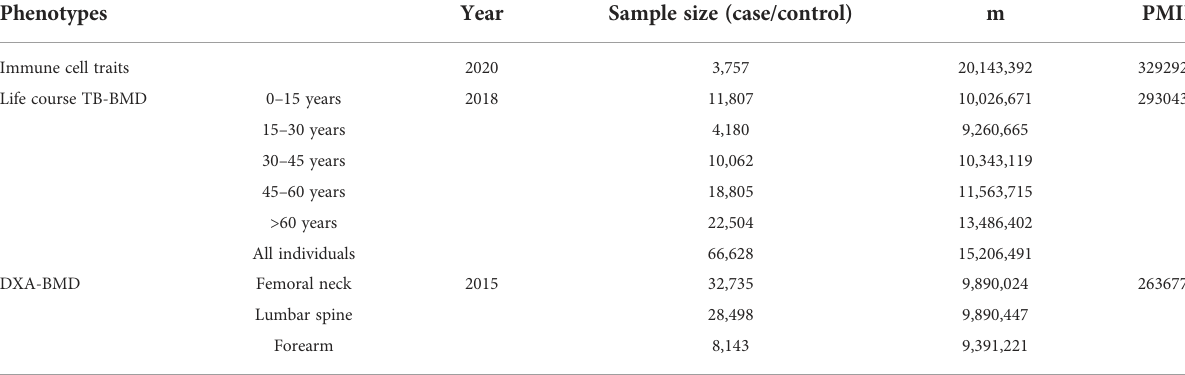
TABLE 1 Summary information for the genetic data used in the present